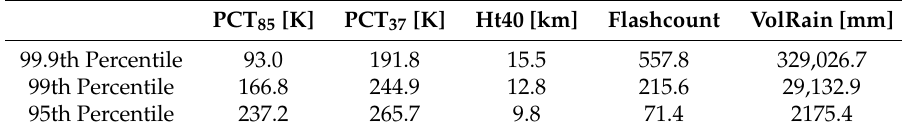
Table 1. Percentiles of the probability distribution function for each